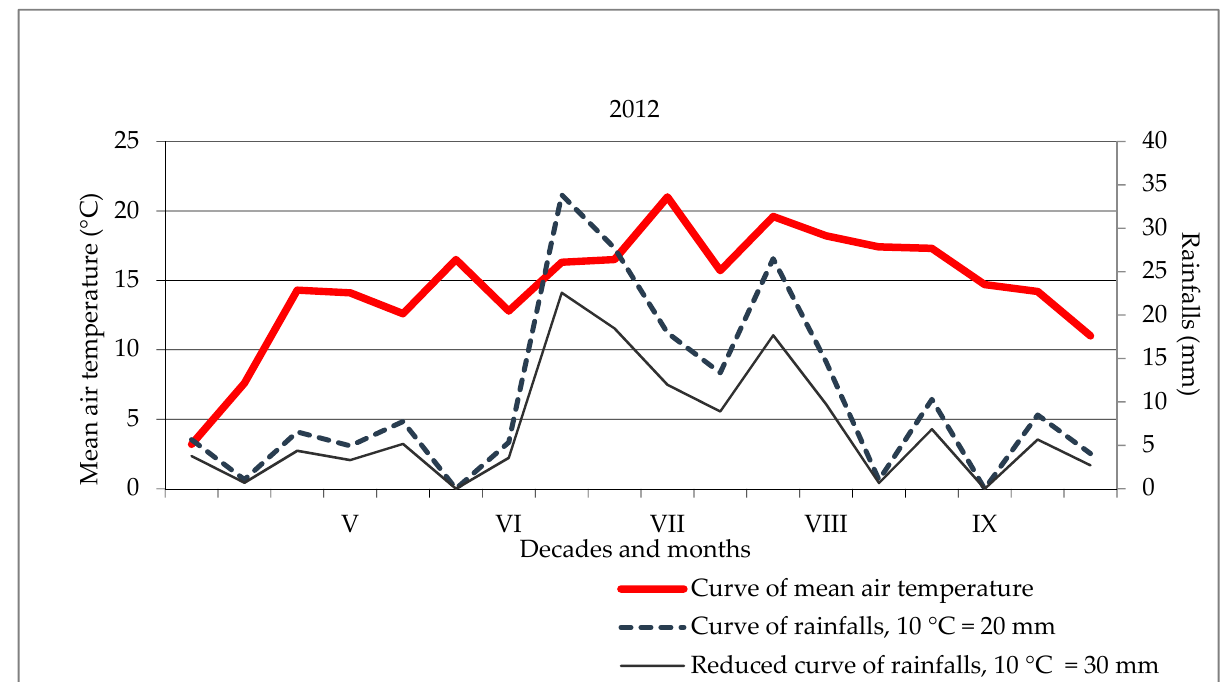
Figure 1. Climatic diagram for meteorological conditions from April to September (IV–IX) in 2011.